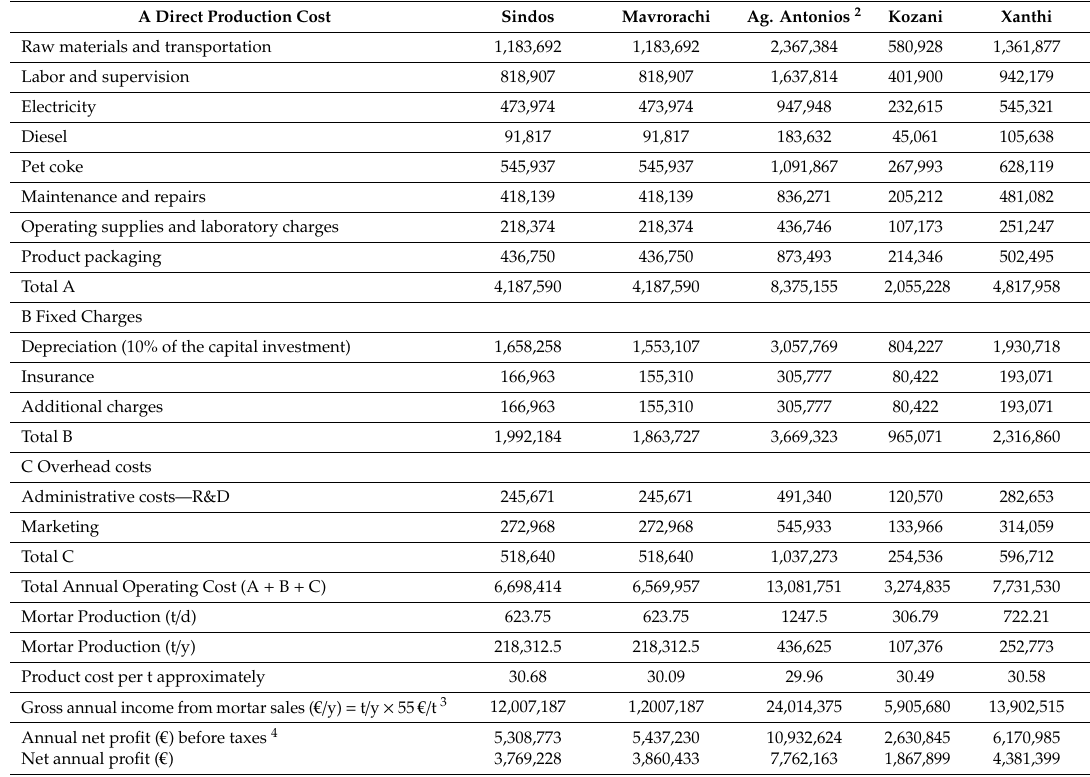
Table 8. Operating cost estimations. Analysis per year in ( € ) 1 of the ZWMP plants of Sindos, Mavrorachi, Ag. Antonios I / II. Kozani and